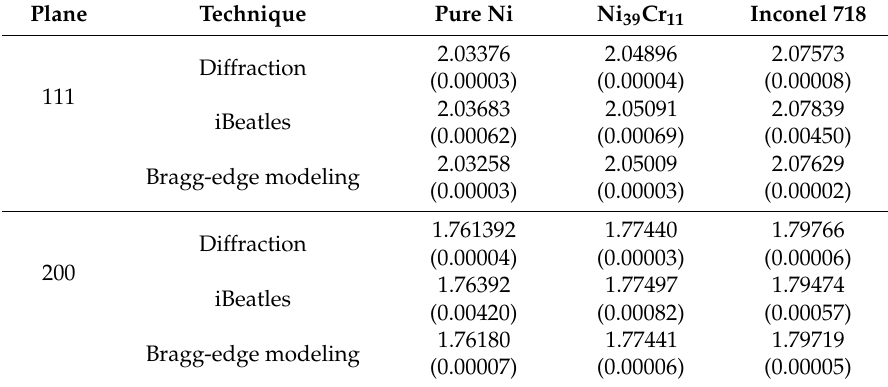
Table 2. The (111) and (200) interplanar spacings (in Å) of pure Ni, Ni 39 Cr 11 , and Inconel 718 powder samples derived by neutron diffraction and transmission results. The transmission results were analyzed by iBeatles and Bragg-edge modeling fitting. The values in parentheses represent the fitting